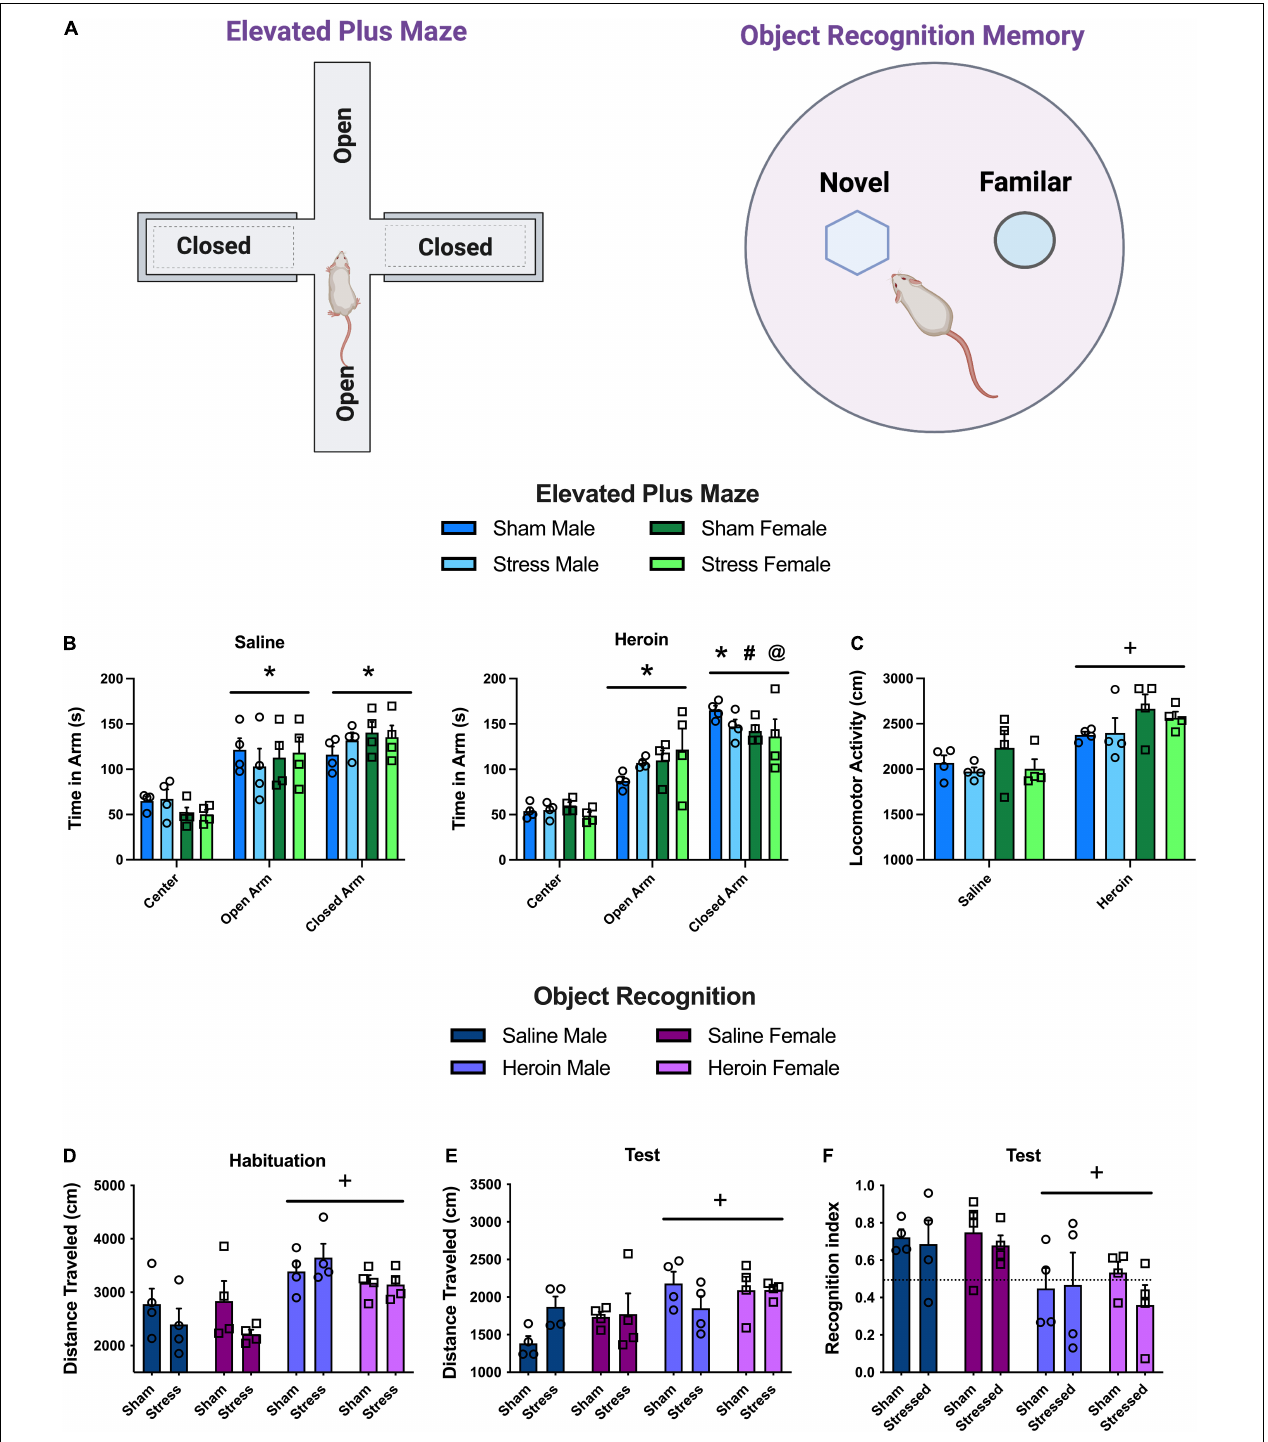
FIGURE 4 | Experiment 4: anxiety and memory following stress and heroin exposure. (A) Schematics of behavioral apparatuses used in Experiment 4. (B) Time spent in the center compartment, open and closed arms of the elevated plus maze. Heroin rats spent more time in the closed arm relative to the open arm and to saline rats in the closed arm. (C) Total distance traveled on the elevated plus maze. Heroin rats were more active on the maze than saline rats. (D) Distance traveled on the habituation day of object recognition memory in a round open field. Heroin rats were more active than saline. (E) Recognition index (approach to novel object/approach to both objects) during object recognition memory test. Heroin rats had lower recognition indices than saline rats. Data are represented as group means ± SEM with individual values. * indicates significant difference from time in center, p < 0.05. # indicates significant difference from time in open arm, p < 0.05. @ indicates significant difference from time in closed arm relative to saline, p < 0.05. + indicates significant difference from saline, p < 0.05.